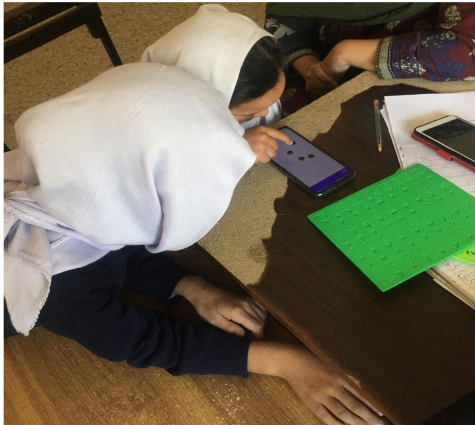
Figure 2. Visually Impaired student entering Braille patterns using a touchscreen